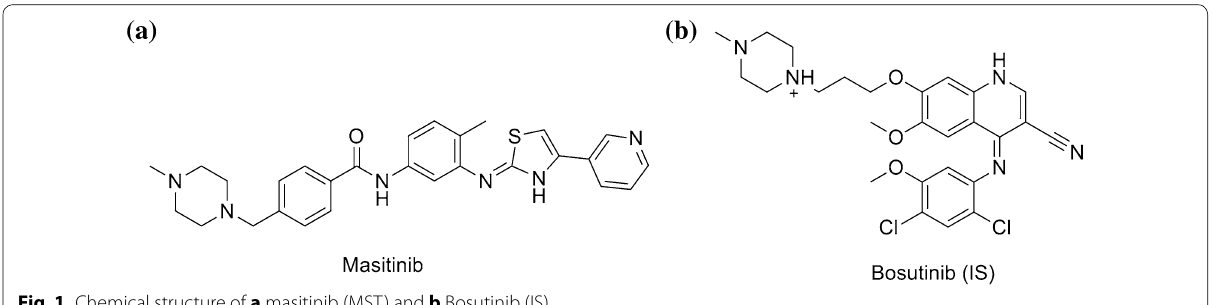
Fig. 1 Chemical structure of a masitinib (MST) and b Bosutinib